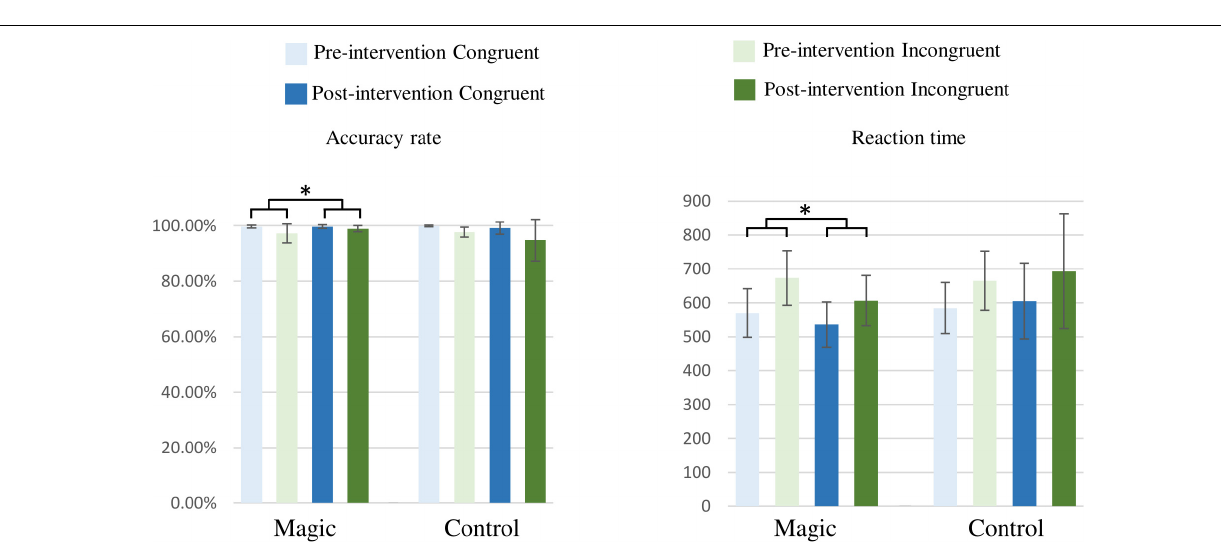
FIGURE 3 | Accuracy rates ( % ) and reaction times (ms) under the congruent and incongruent conditions in the magic intervention group before and after the magic intervention program and in the control group before and after the ordinary daily activity (* p <